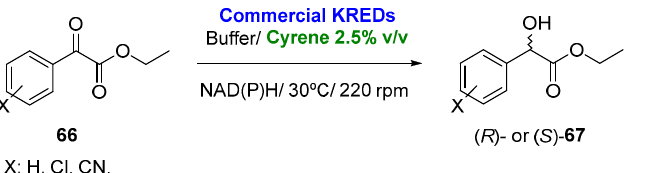
Figure 34. Bioreduction of different α -ketoesters employing KREDs in presence of Cyrene as cosol- vent.